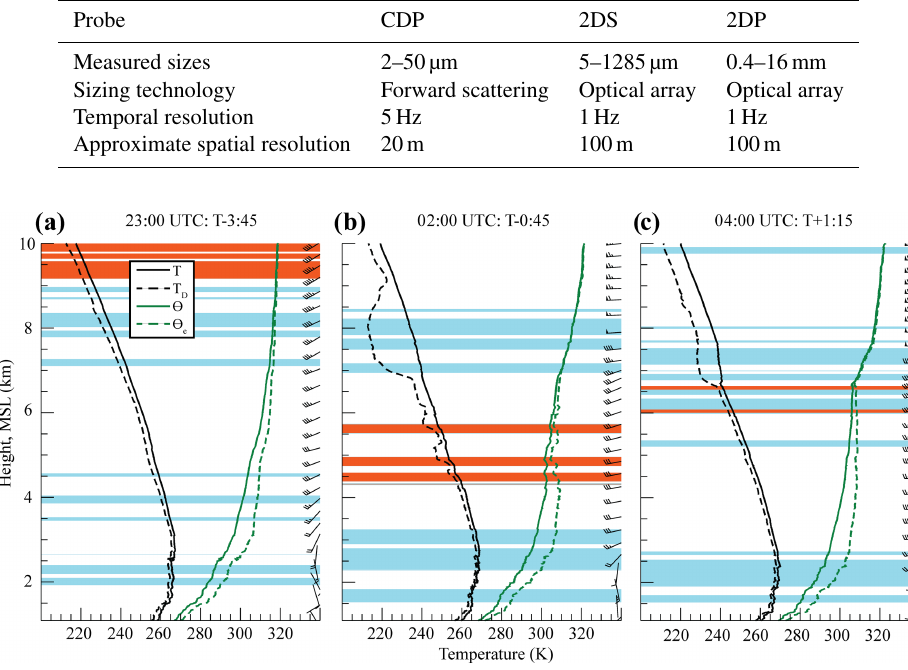
Figure 2. Thermodynamic and dynamic profiles from radiosondes launched at Crouch, ID (KCRH; Fig. 1). Shaded levels correspond to relaxed critical values of the bulk Richardson number, Ri bulk < 0 . 5, after 10pt ( ∼ 50m) vertical smoothing of the field. Orange shading indicates negative bulk Richardson values – corresponding to static instability – and blue corresponds to purely dynamic instability, 0 < Ri bulk < 0 . 5. Relative times ( T ± ) reference the 02:45UTC leg 1 start